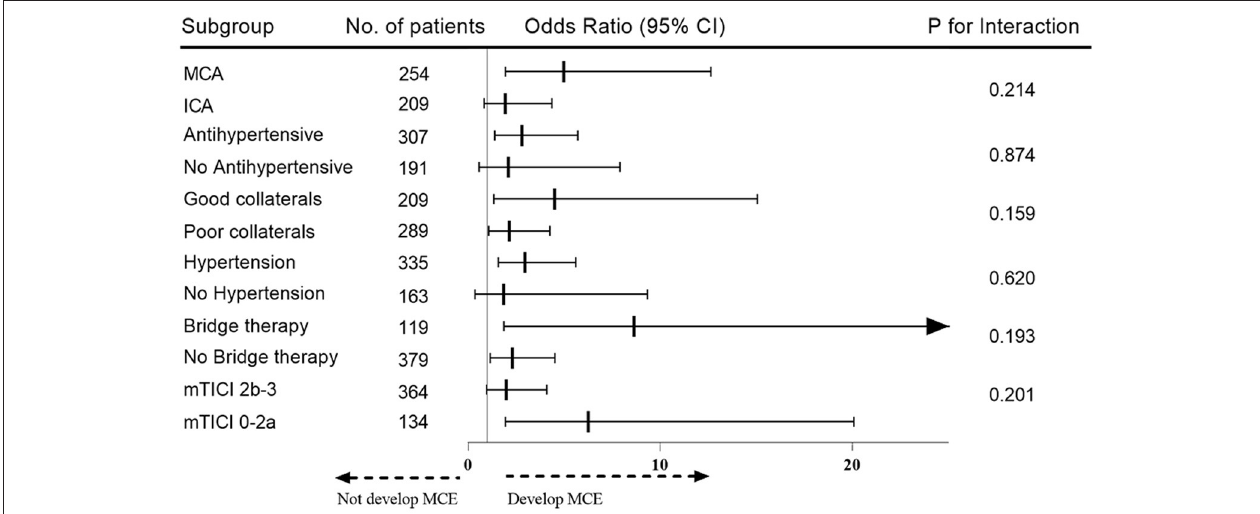
FIGURE 4 | Subgroup analysis for heterogeneity of effect of SBP max > 165 mmHg on the development of MCE. The odds of developing MCE for each subgroup is depicted with a square and a line, representing a 95% CI on the forest plot on the right.